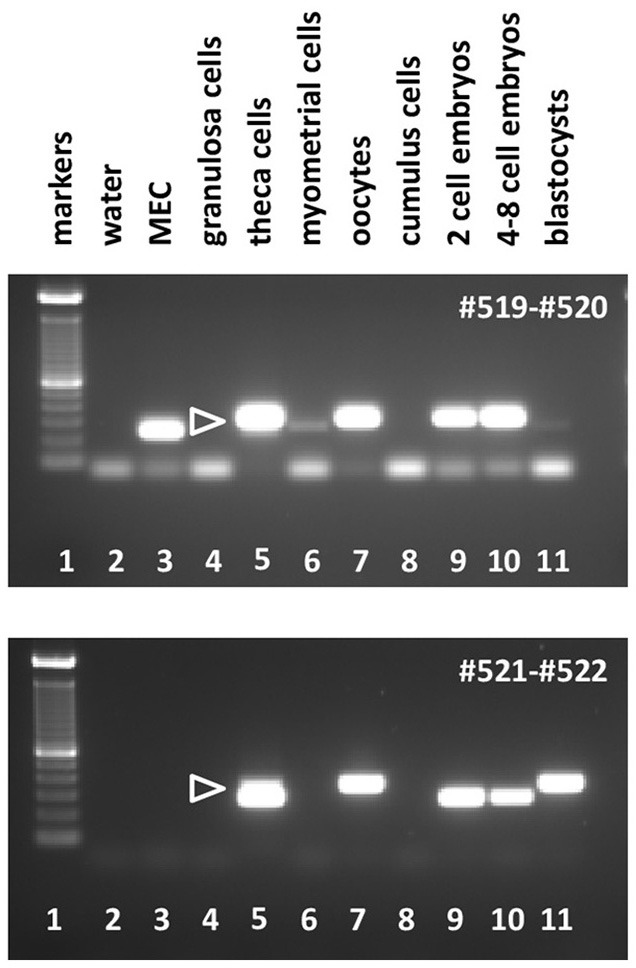
Semi-quantitative RT-PCR analysis for bRXFP2 transcripts of RNA derived from various bovine cells and tissues as indicated, or water controls (lane 2). MEC, bovine mammary epithelial cells. PCR primers used are shown in white within each panel. White triangles indicate the position of the correctly spliced PCR product. A 100 bp DNA ladder is used as size markers in lane 1 within each panel. PCR conditions (primers, annealing temperature, expected size):#519–#520, 62–58°C touchdown, 291 bp; #521–#522, 62–60°C touchdown, 312 bp.